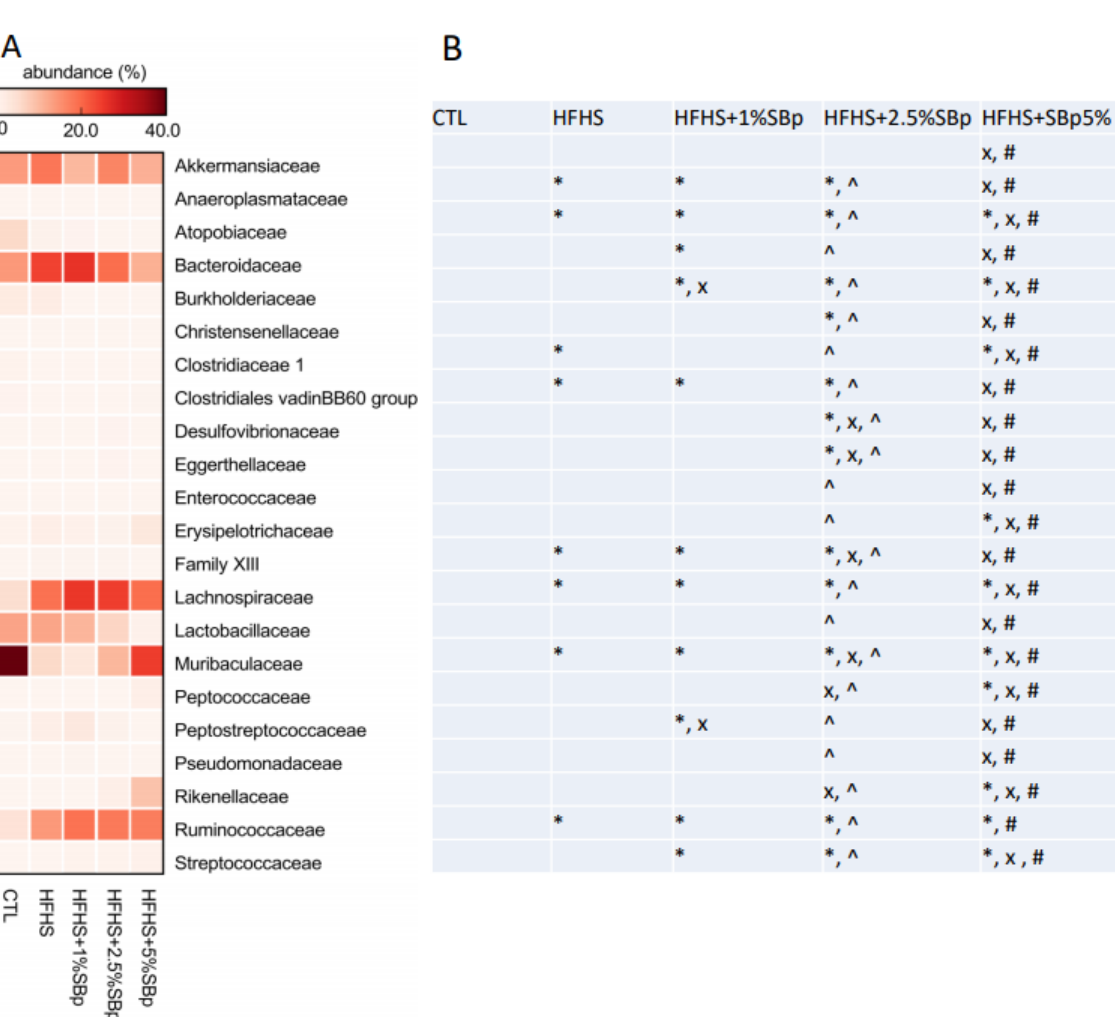
Figure 7. Effect of supplementation of SBp on the relative abundance of gut family bacteria. The experimental regimen was described in the legend of Figure 4. ( A ) Heat map of family bacteria; ( B ) statistical differences among mice with different diets (ANOVA and post-hoc Tukey test). *: p < 0.05 vs. control (CRL); x p < 0.05 vs. HFHS group; ˆ: p < 0.05 vs. 1% SBp; #: p < 0.05 vs. 2.5% SBp.